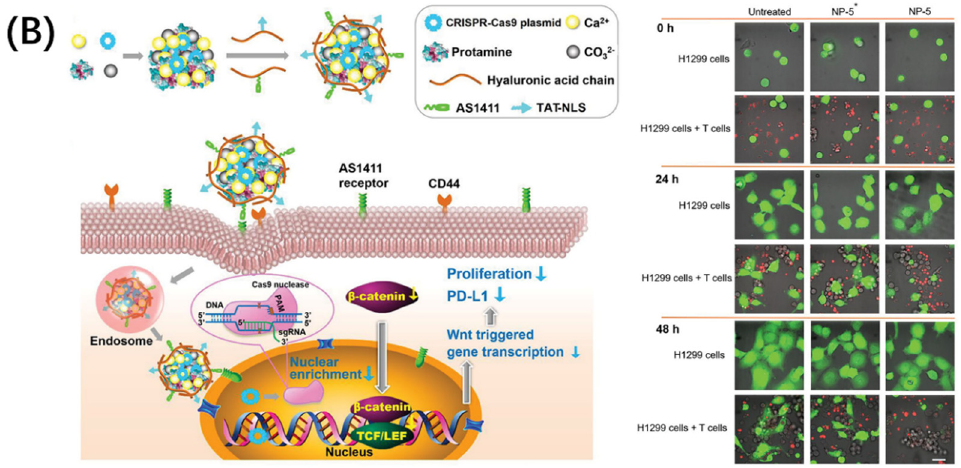
Figure 2. Peptide-functionalized nanomaterials for immune checkpoint blockade. ( A ) iRGD-modi- fied nanoparticles, DOX@MSN-SS-iRGD&1MT, simultaneously delivered chemotherapeutic agent